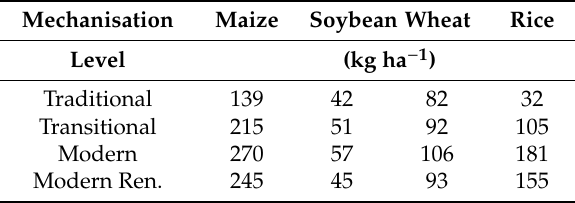
Table 6. N-based fertiliser Inputs by Crops and Mechanisation levels.